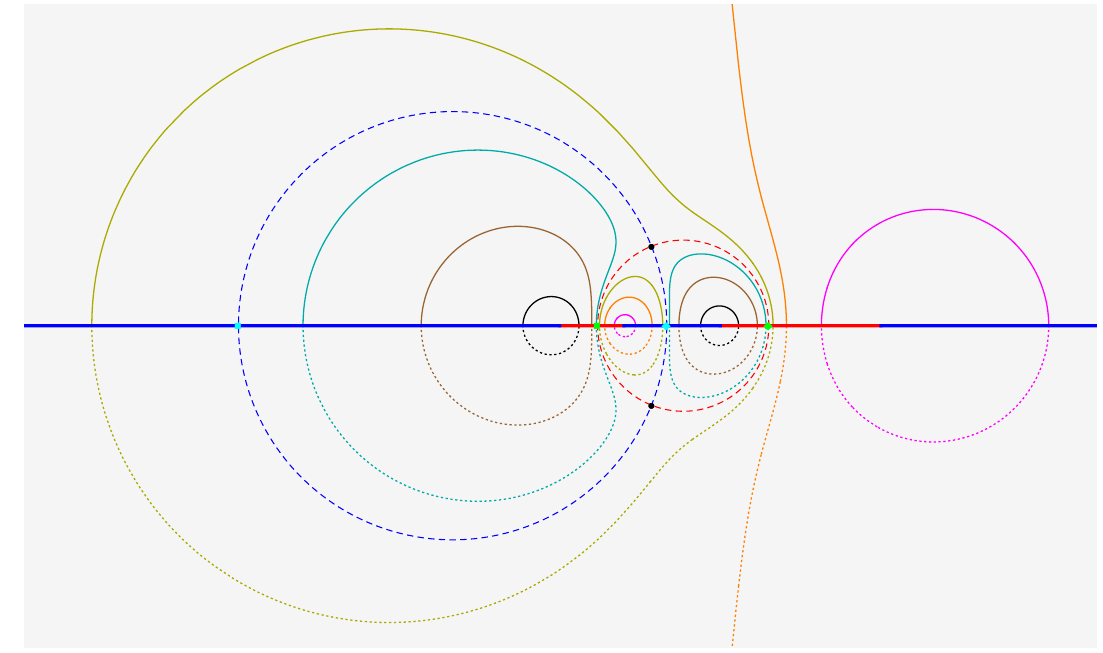
Figure 12 . Euclidean modular evolution for the union A = A 1 ∪ A 2 of two disjoint intervals (red seg- ments), from (7.23) with either θ ∈ (0 , π ) (solid lines) or θ ∈ ( π, 2 π ) (dotted lines), which lead to the inversion map (7.29) on the line. Curves having the same colour correspond to conjugate points in A